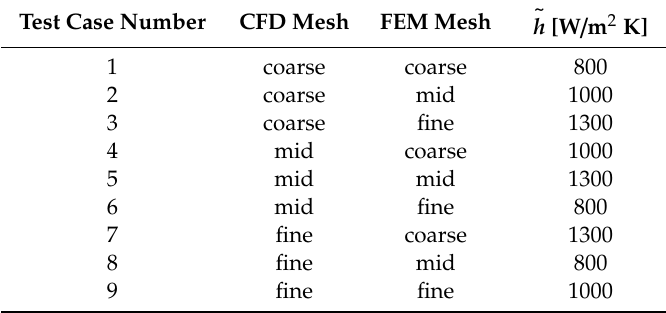
Table 4. L9 Orthogonal Array applied to the turbine rotor CHT